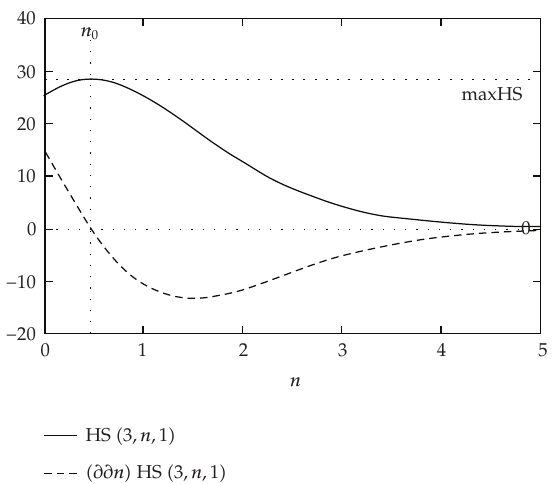
Figure 6: The contour function of the hypersolid HS (cid:2) 3 ,n, 1 (cid:3) with the local maximum max HS ≈ 28 . 379 and the optimal degree of freedom n 0 ≈ 0 . 4616, for k ∈ N